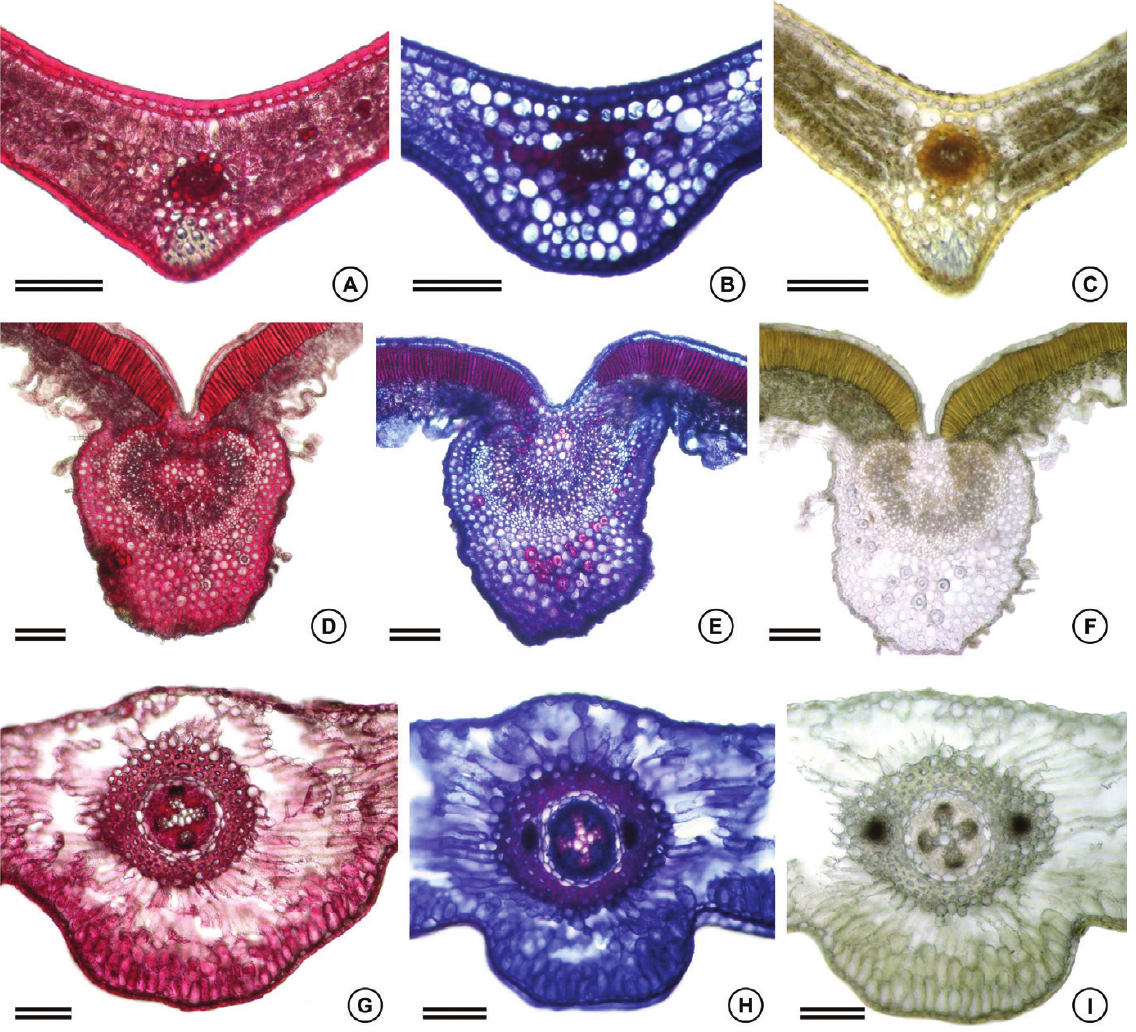
Figure 1 - Cross sections of leaves of Lavoisiera pectinata (A-C) , Trembleya parviflora (D-F) and stem of Lycopodium clavatum (G-I) . A , D and G . Tissues treated with Aluminon. B , E and H . Tissues treated with Chrome Azurol. C , F and I . Blank test. Bars length = 100